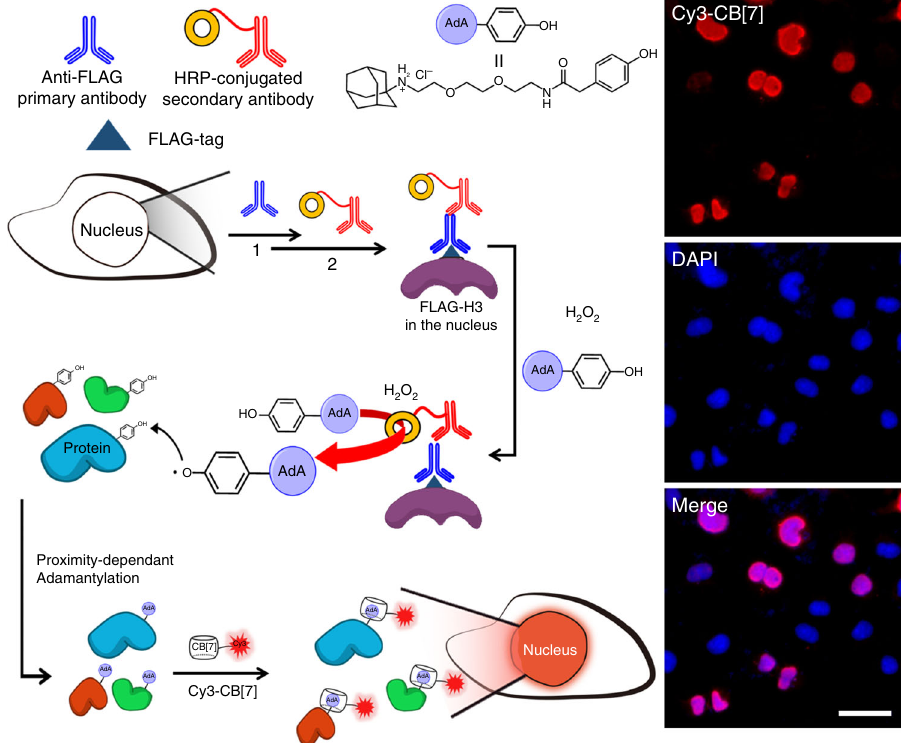
Fig. 5 Visualization of nuclear proteins. Schematic illustration for proximity-dependent adamantylation of nuclear proteins using immunoselectively introduced HRP on histone H3 and fl uorescence microscopy images of the fi xed COS7 cells which have FLAG-histone H3 expressed in the nucleus. Scale bar = 20 μ